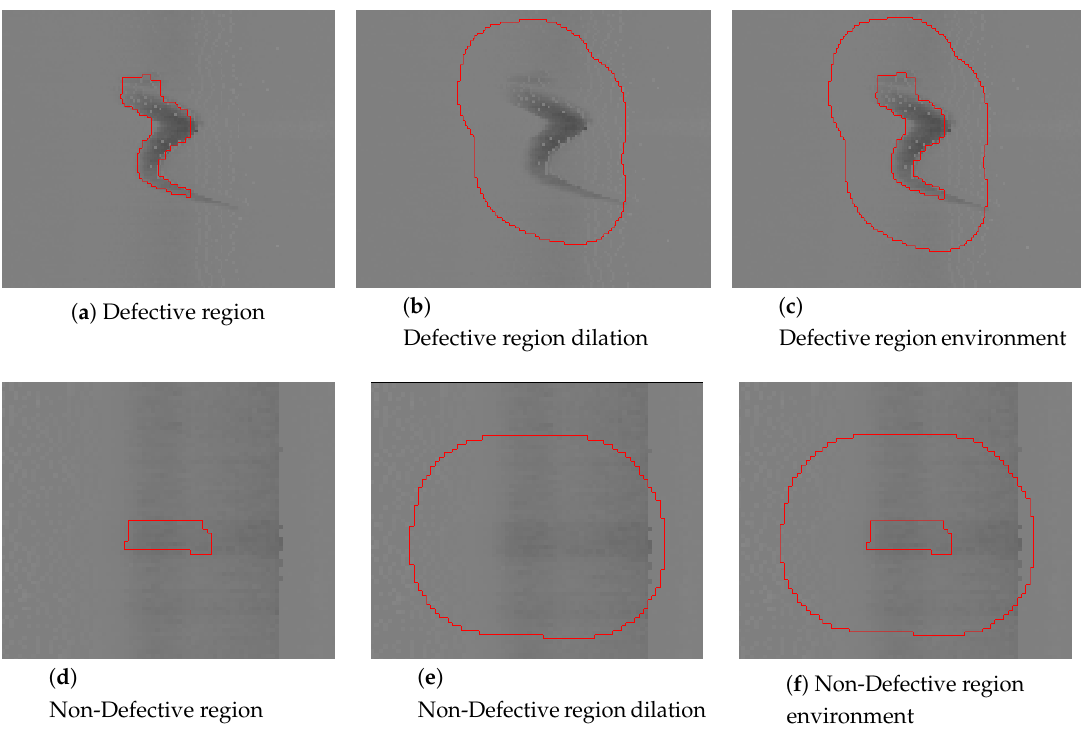
Figure 7. Region environment